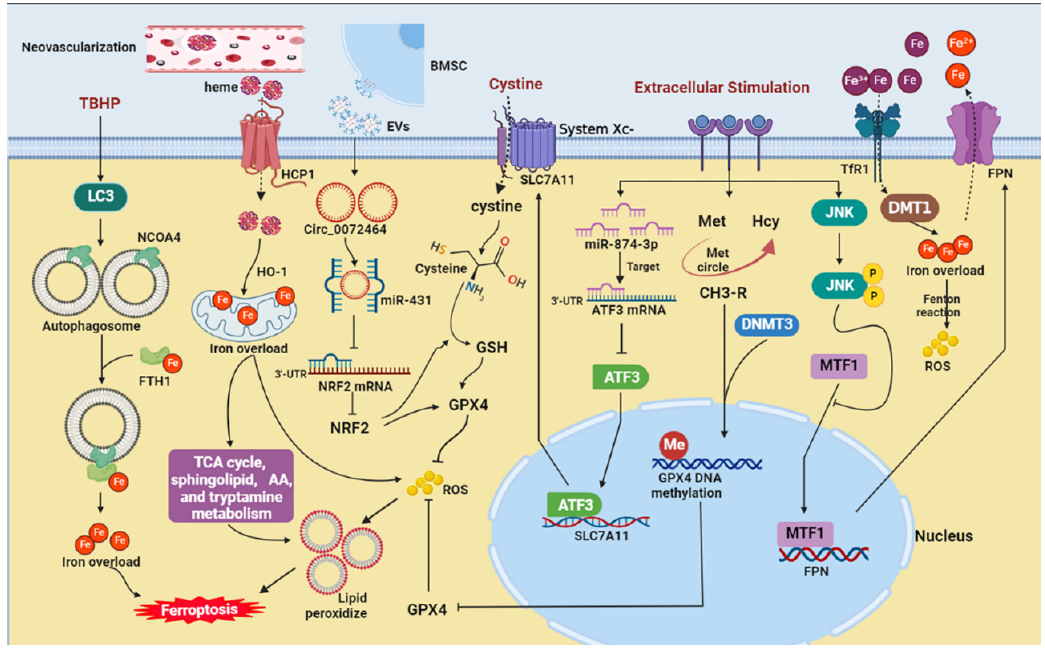
Figure 1. The potential ferroptosis-related pathways in nucleus pulposus cells. AA, arachidonic acid; ATF3, activation transcription factor 3; BMSC, bone marrow mesenchymal stem cell; DMT1, divalent metal transporter 1; DNMT3, DNA methyltransferase 3; EVs, extracellular vesicles; FTH1, ferritin heavy chain 1; FPN, ferroportin; GPX4, glutathione peroxidase 4; GSH, glutathione; HCP1, heme carrier protein 1; Hcy, homocysteine; HO-1, heme oxygenase-1; JNK, c-jun N-terminal kinase; LC3, microtubule-associated protein light chain 3; Met, methionine; MTF1, metal-regulatory transcription factor 1; NCOA4, nuclear receptor coactivator 4; NRF2, nuclear factor E2-related factor 2; ROS, reactive oxygen species; SLC7A11, cystine/glutamate antiporter; TBHP, tert-butyl hydroperoxide; TCA, tricarboxylic acid; TfR1, transferrin receptor 1.